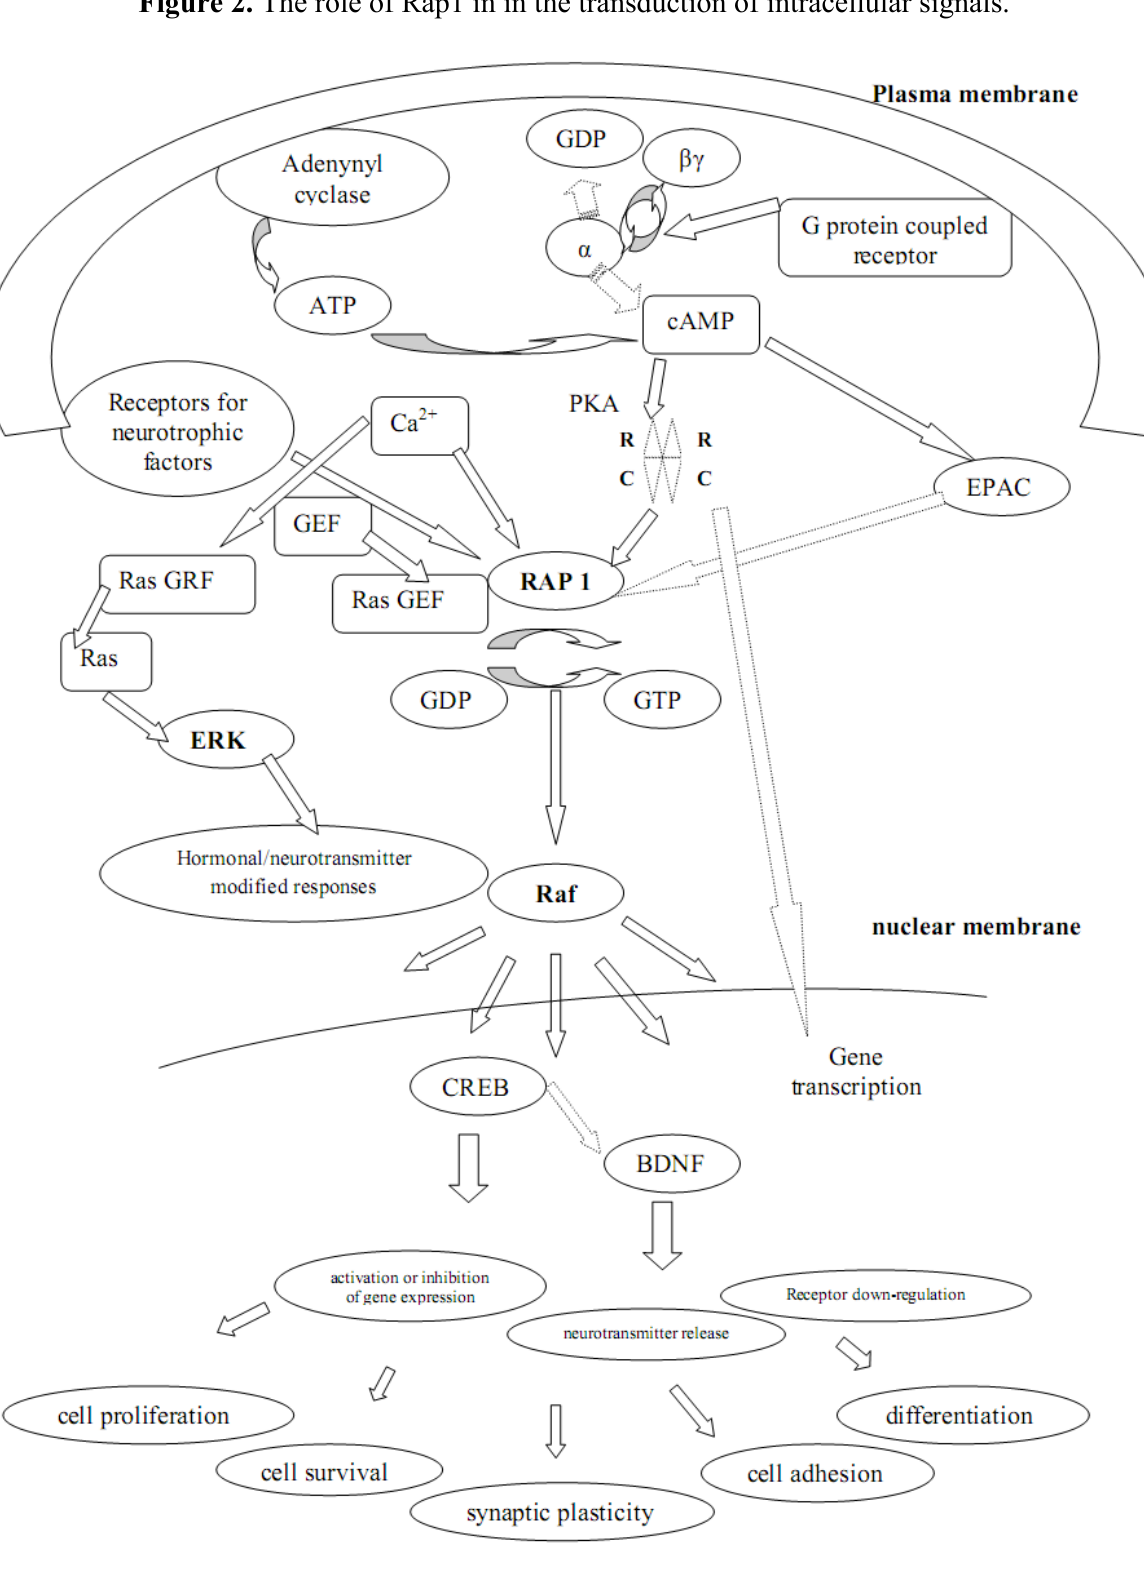
Figure 2. The role of Rap1 in in the transduction of intracellular